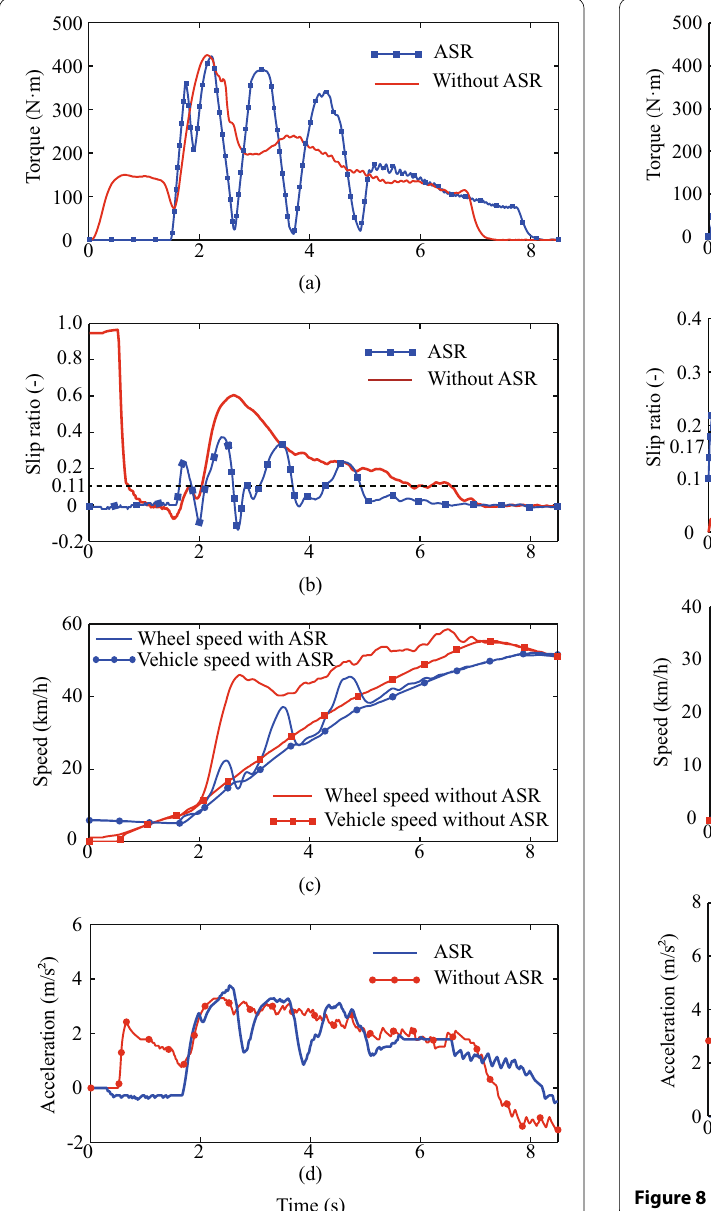
Figure 7 Vehicle test under wet road condition